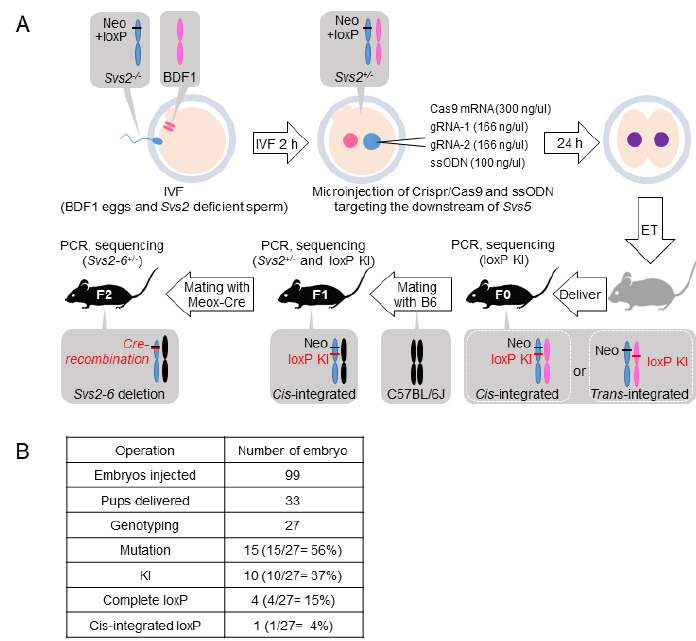
Figure 3. Experimental scheme for generating Svs2-6 -/- mice. ( A ) Co-injection of gRNAs, Cas9 mRNA, and ssODN into fertilized BDF1 eggs with Svs2 -deficient sperm. The loxP cassette should be cis-integrated with blue chromosomes carrying Neo-loxP from Svs2 -/- mice. ( B ) Summary of the efficiency in CRISPR/Cas9 and ssODN induced mutations and loxP-knockin mice.